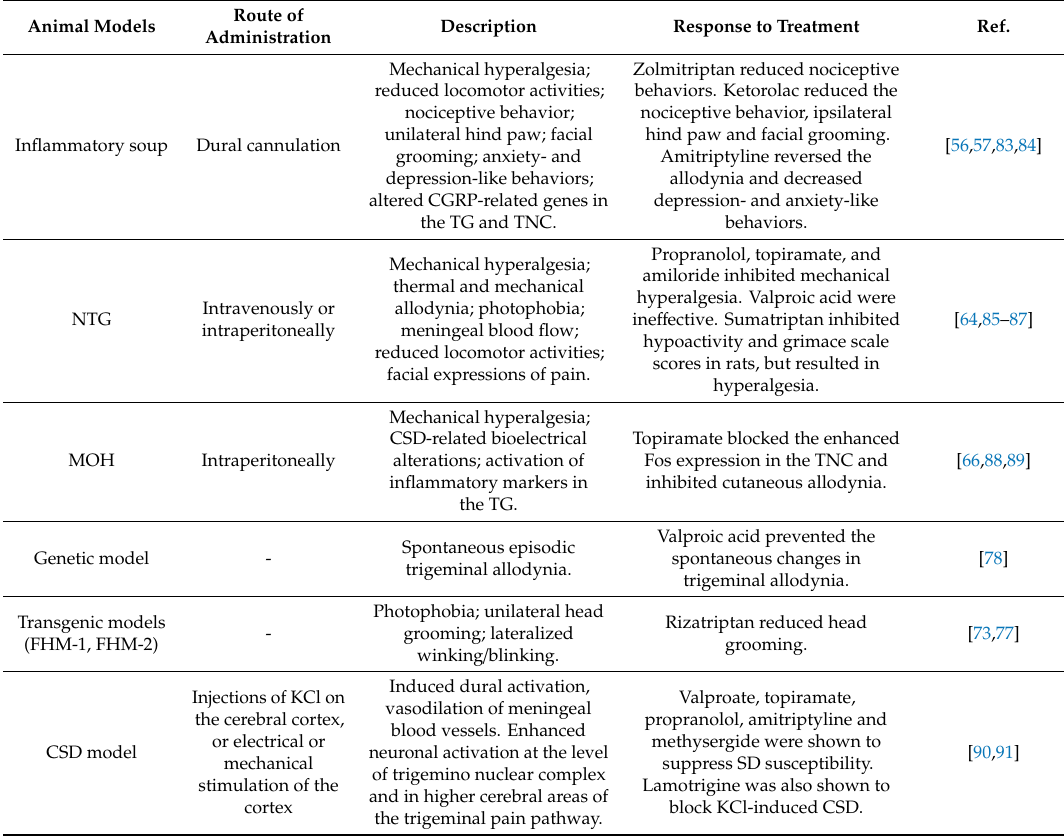
Table 3. Current animal models of